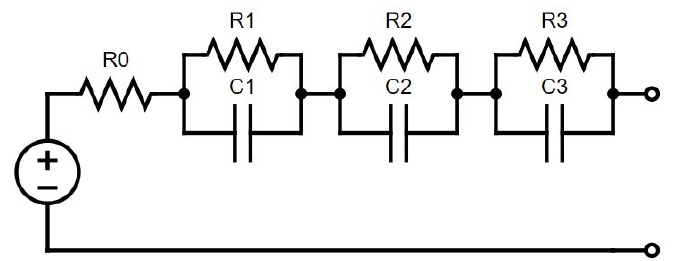
Figure 1. Schematic of a third-order equivalent circuit.